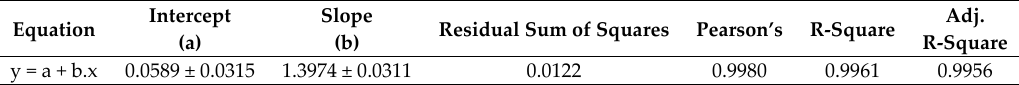
Figure 2. ( a ) Nonlinear calibration curve for freshwater obtained by acid calibration and ( b ) linear curve for the same calibration using the logarithm of the CO 2 concentration. Table 1. Calibration values obtained from data represented in Figure 2b.